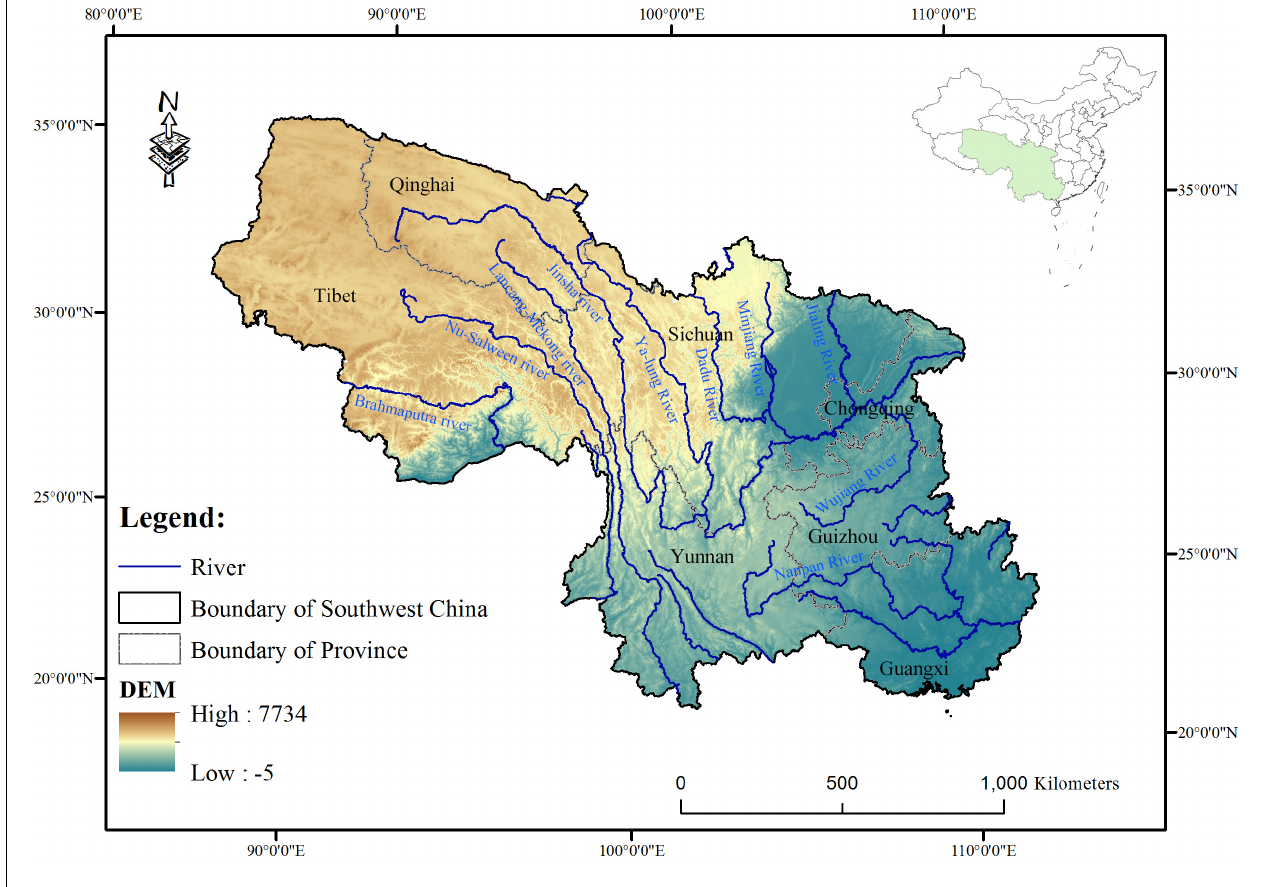
FIGURE 1 | Location of study area.